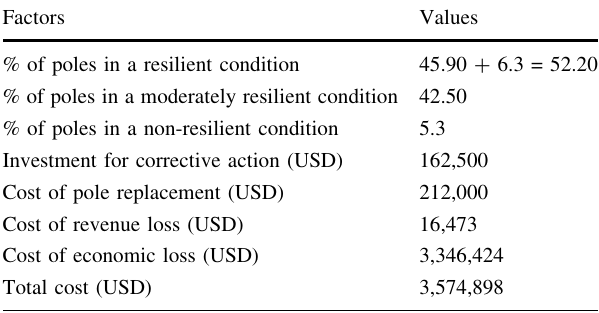
Table 7 Results for Strategy 2